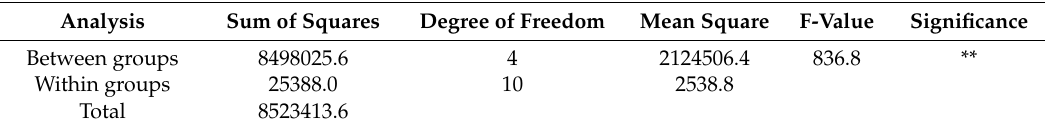
Table 6. One-way analysis of variance (ANOVA) for high-temperature rutting test. Analysis Sum of Squares Degree of Freedom Mean Square F-Value Significance Between groups 8498025.6